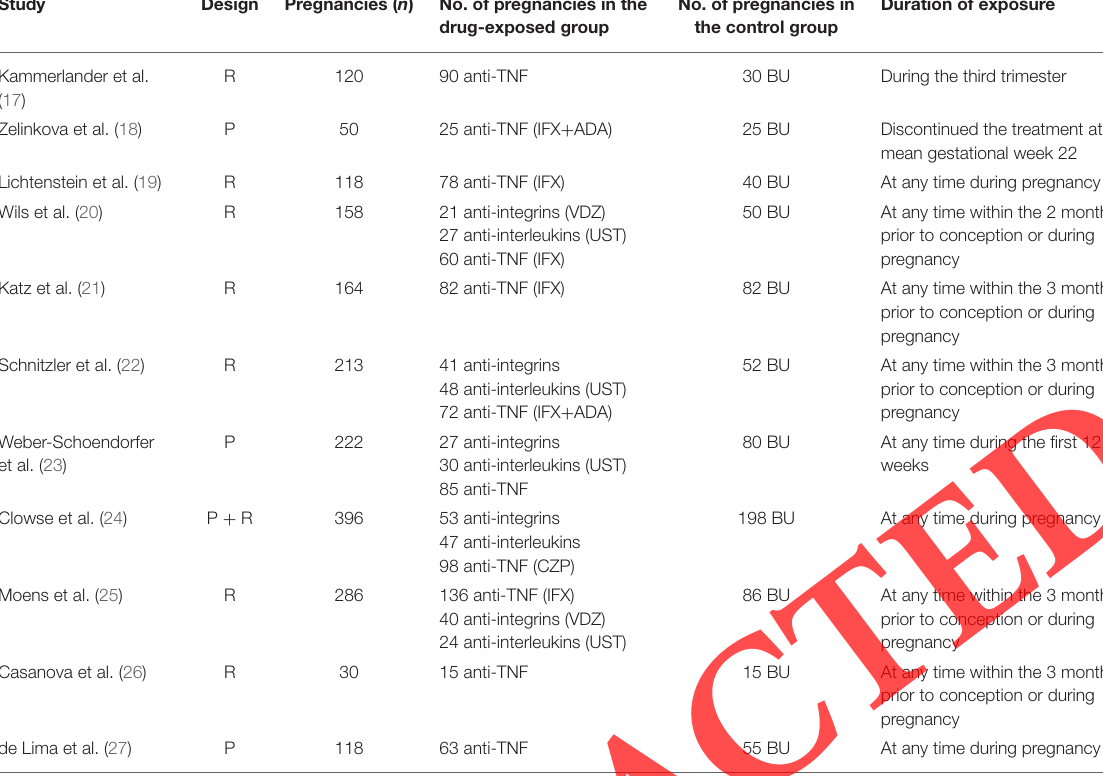
TABLE 2 | Pregnancy outcomes (proportion of adverse outcomes to the number of exposed pregnancies) of included studies. Outcomes